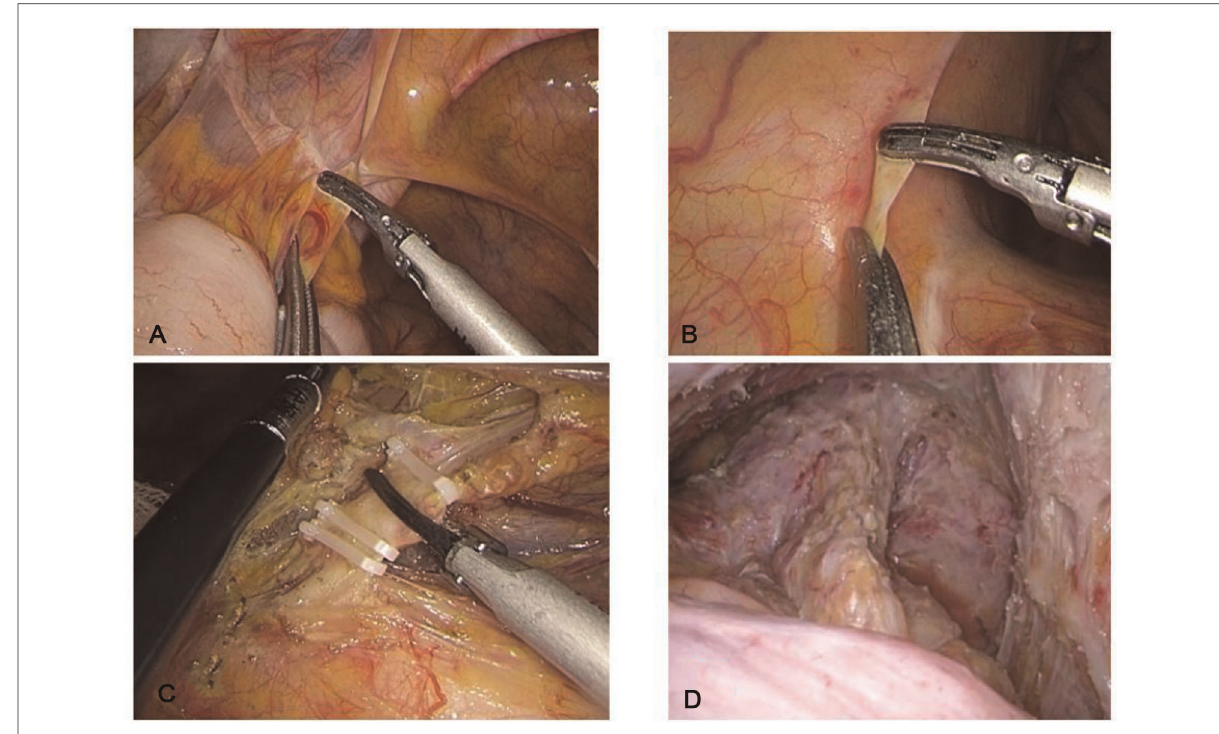
FIGURE 1 3D or 2D laparoscopy to complete the abdominal cavity operation, ( A ) Separation of the lateral physiological adhesions; ( B ) The peritoneum was incised at the level of the sacral promontory; ( C ) Disconnection of the inferior mesenteric vessels; ( D ) Dissociation to the level of the upper edge of the levator